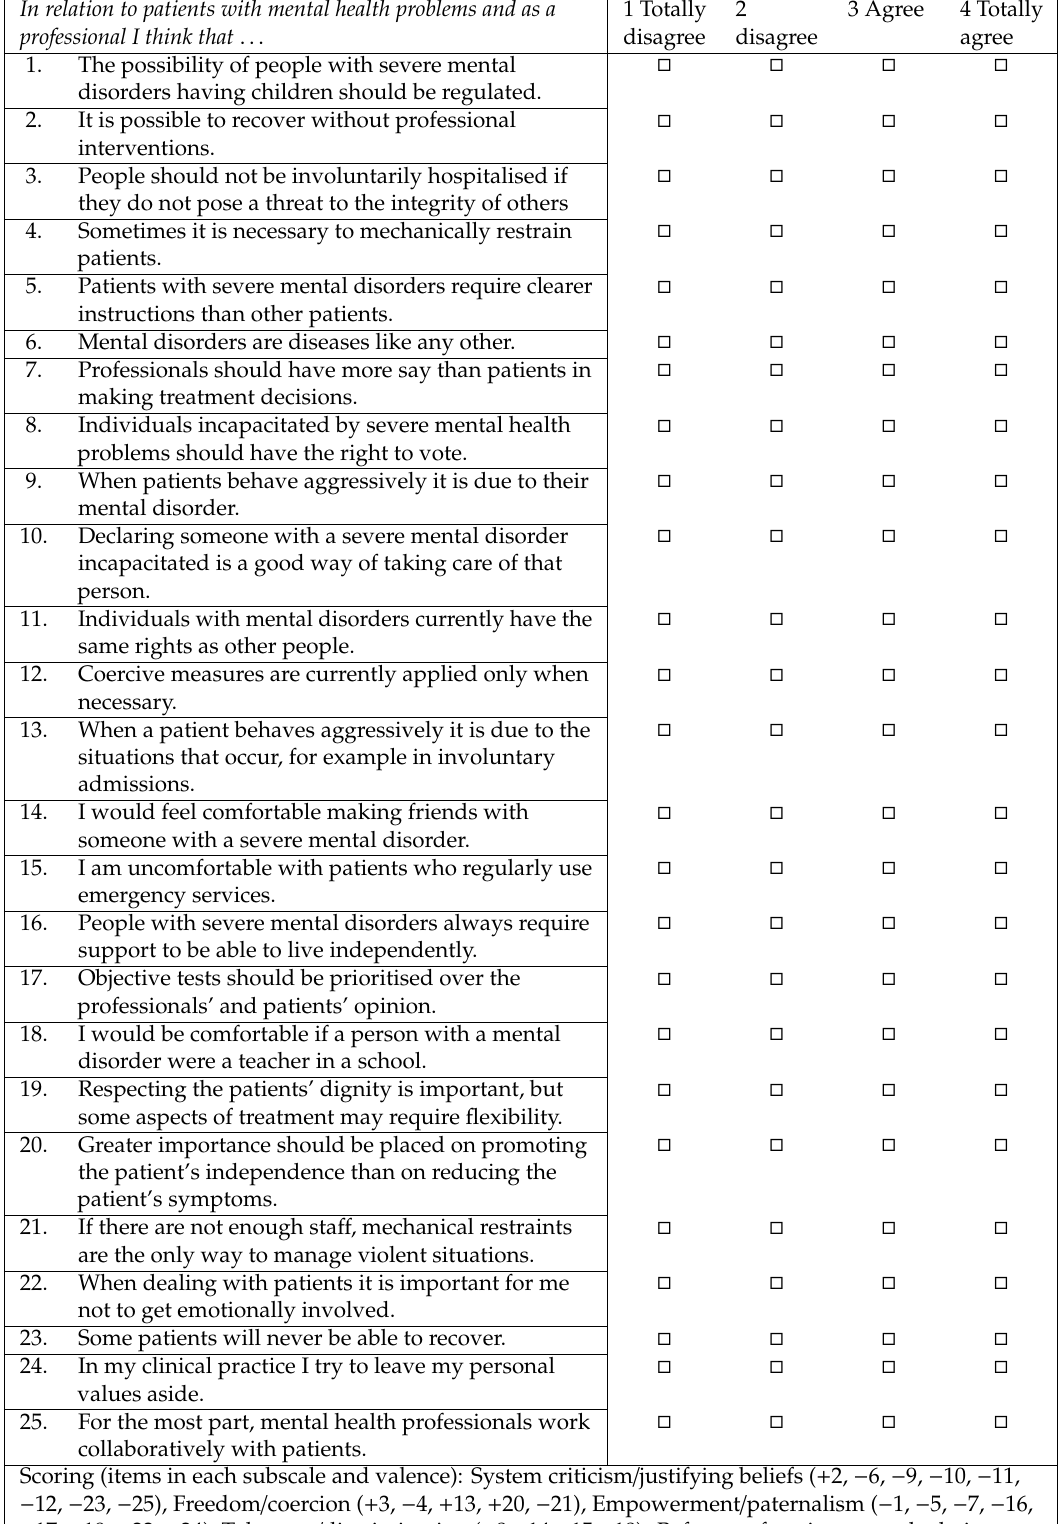
Table 5. English version of the Beliefs and Attitudes towards Mental Health Service Users’ Rights Scale including scoring